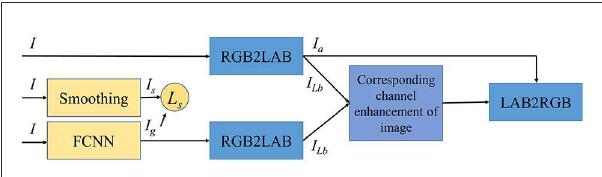
FIGURE1 The process of aggregating an image.